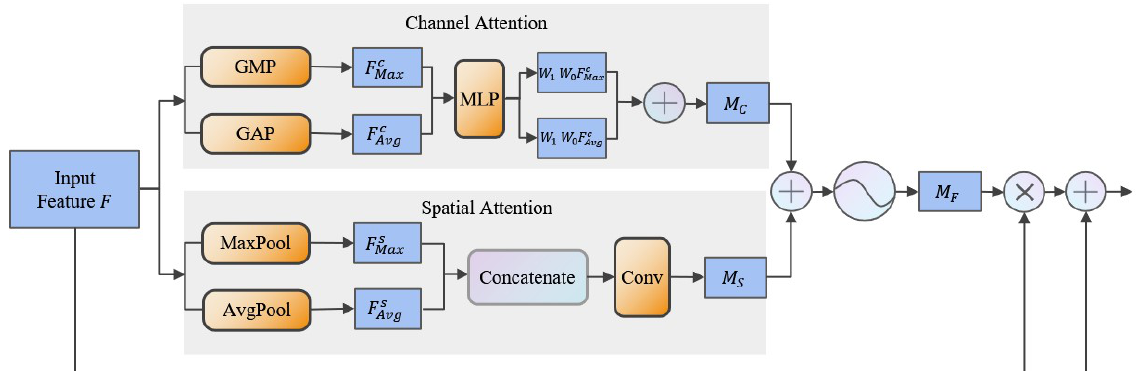
Figure 6. A plug-and-play dual-attention module with parallel residual connection to refine the feature extract by the multi-branch blocks mentioned in Figure